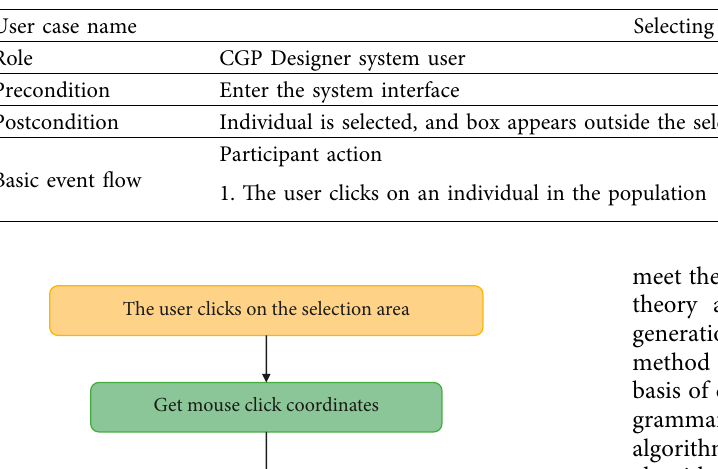
Table 4: Use case rules for selecting individual.